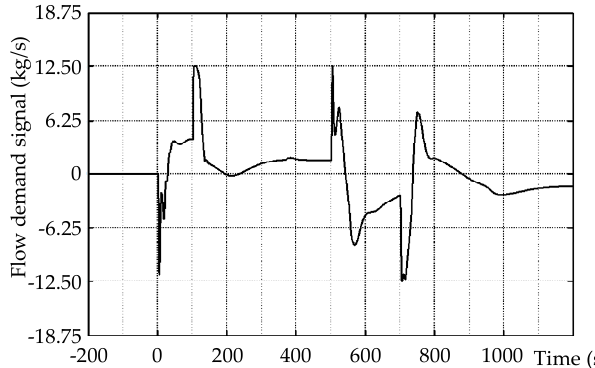
Figure 11. DMC supplementary air flow demand of 600-MW plant.